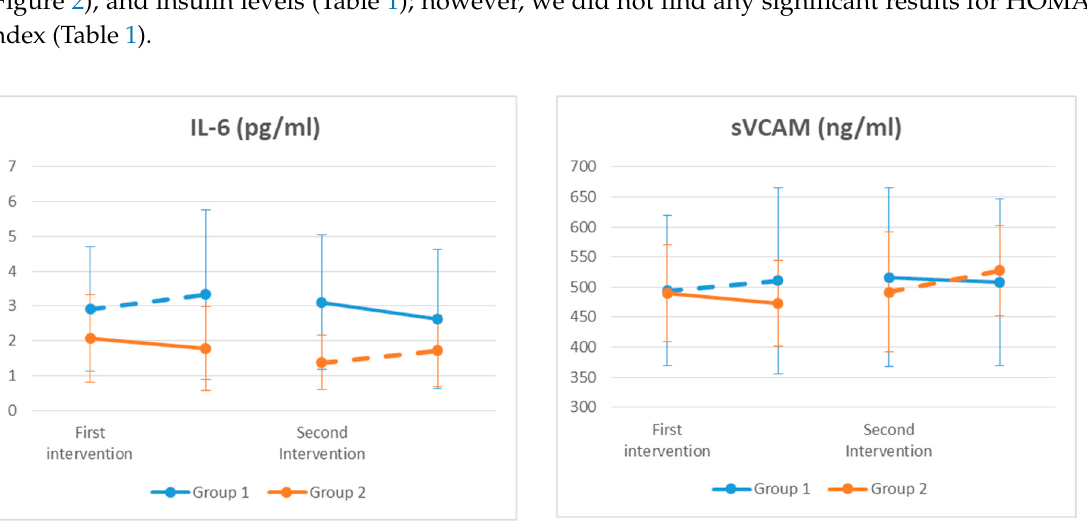
Figure 2. Inflammatory biomarkers throughout the study. The levels of interleukin 6 (IL-6) and soluble vascular cell adhesion molecule 1 (sVCAM) were modified by the probiotic consumption ( p < 0.05). Continuous line: probiotic group. Discontinuous line: placebo group.